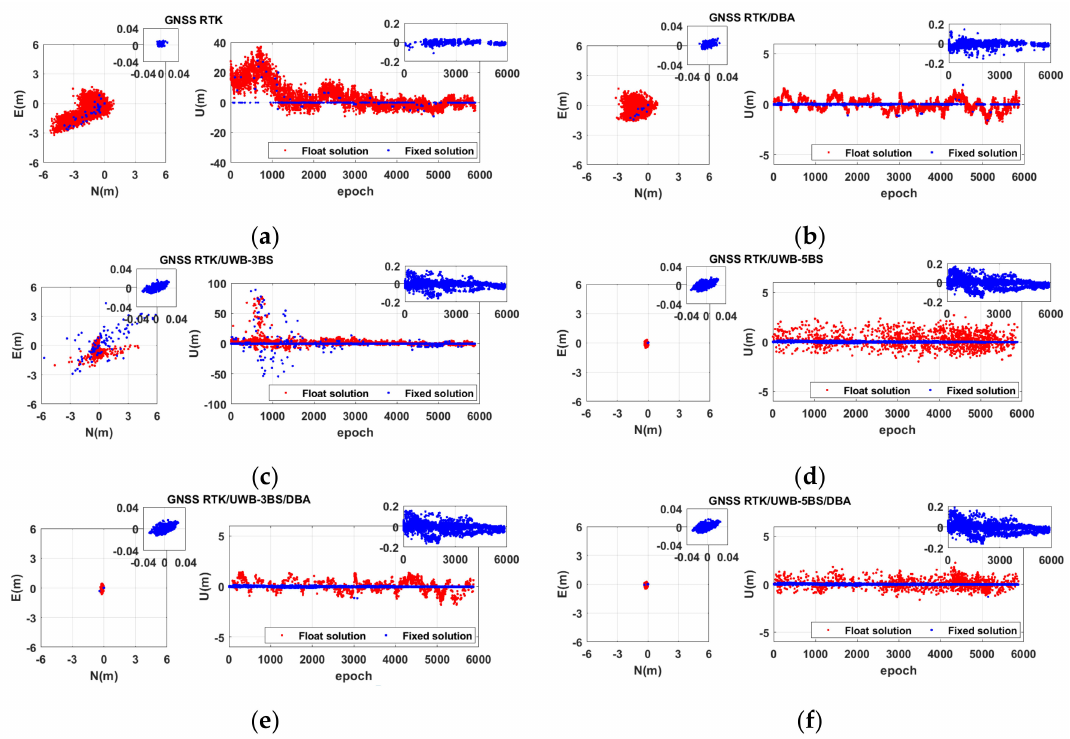
Figure 8. GNSS RTK/UWB/DBA fusion positioning model error in the N/E/U directions at a 50 degree elevation mask angle: ( a ) GNSS RTK; ( b ) GNSS RTK/DBA; ( c ) GNSS RTK/UWB − 3BS; ( d ) GNSS RTK/UWB − 5BS; ( e ) GNSS RTK/UWB − 3BS/DBA; ( f ) GNSS RTK/UWB −